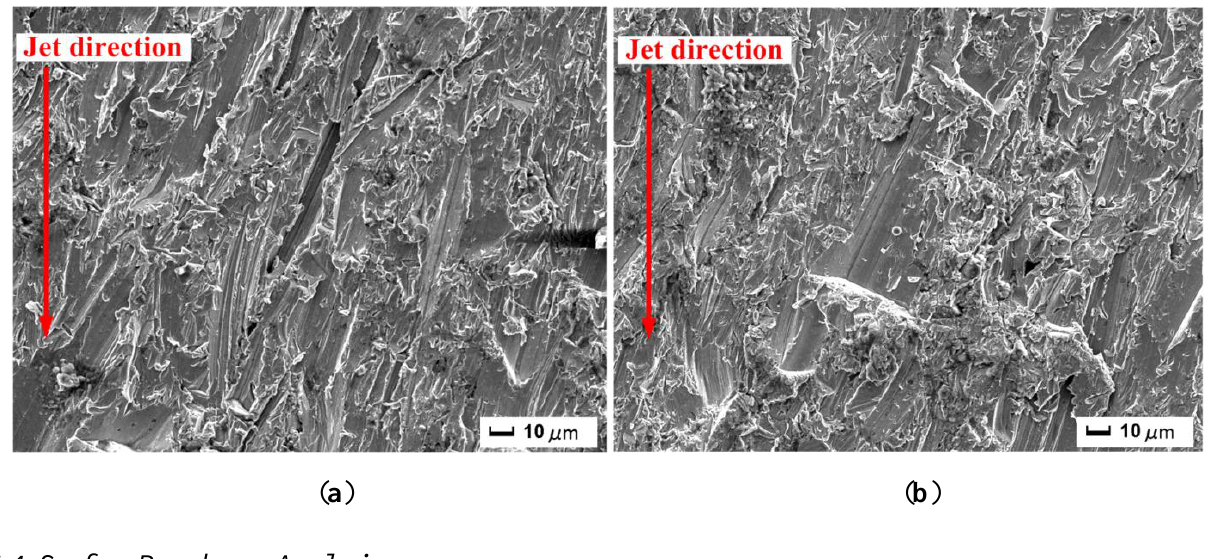
Figure 7. Surface morphological features on cut sections: ( a ) Z = 3.0 mm; ( b ) Z = 7.0